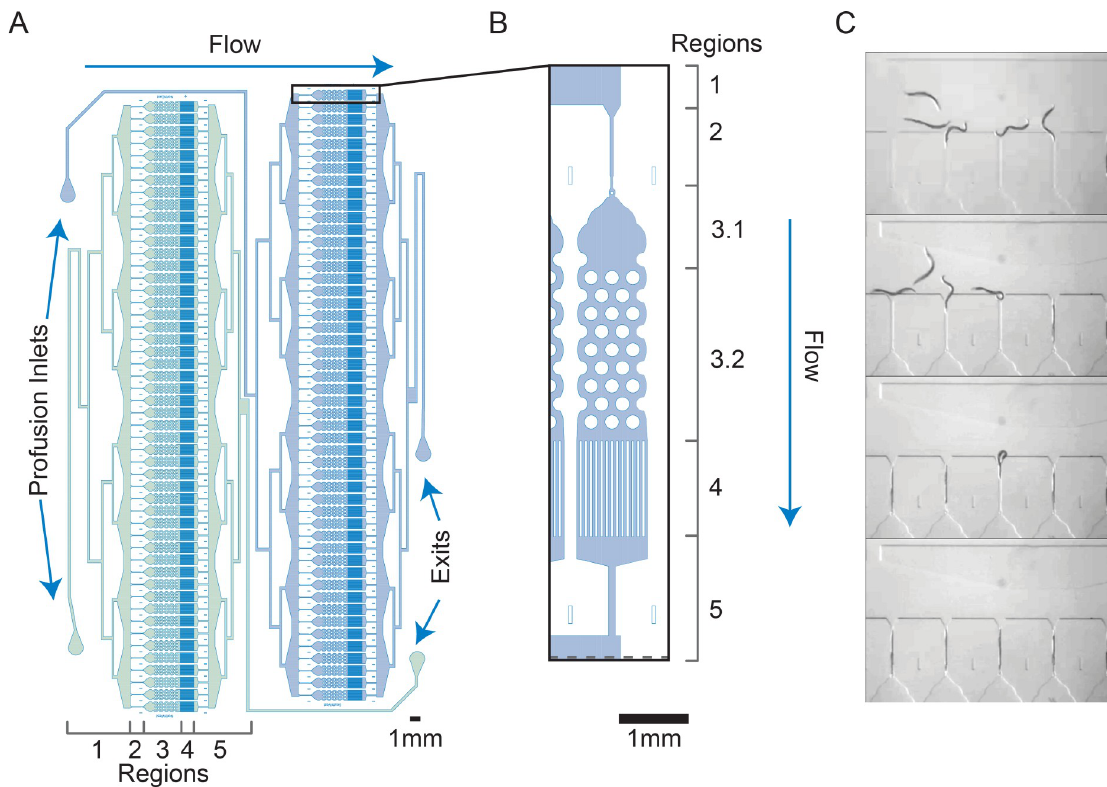
Fig 1. Microfluidic device for parallelized low-density worm culture. (A) The microfluidic chip is designed to have two arrays of 50 growth arenas. Flow through the system enters in region 1, a perfusion inlet on one side of the chip connected to a distribution network that ends in an open space upstream of the loading chambers. Flow then passes through the loading chambers (region 2) and enter the growth arenas (region 3). Flow exits each of the growth arenas through a filter (region 4) and reconnects to a single outflow network (region 5). The exit ports at the end of region 5 are located on the opposite side of the chip from the perfusion inlets to avoid shadowing by overhanging tubing. (B) Each arena includes a 2.2 mm x ~0.9 mm “crawl-zone” of 0.2 mm diameter pillars spaced 0.1 mm apart (see [12]) (region 3.2). Upstream of the pillar array is a “swim zone” (region 3.1) that stretches 1.1 mm from entry point to the first set of pillars. The combination of an entry plug and flow keeps loaded animals in the arenas. (C) Automated loading is facilitated by holding chambers with 0.028 mm wide constriction points that enable the parallel pre-loading of 50 animals which are then moved into the chambers with a short burst of increased pressure (adapted from